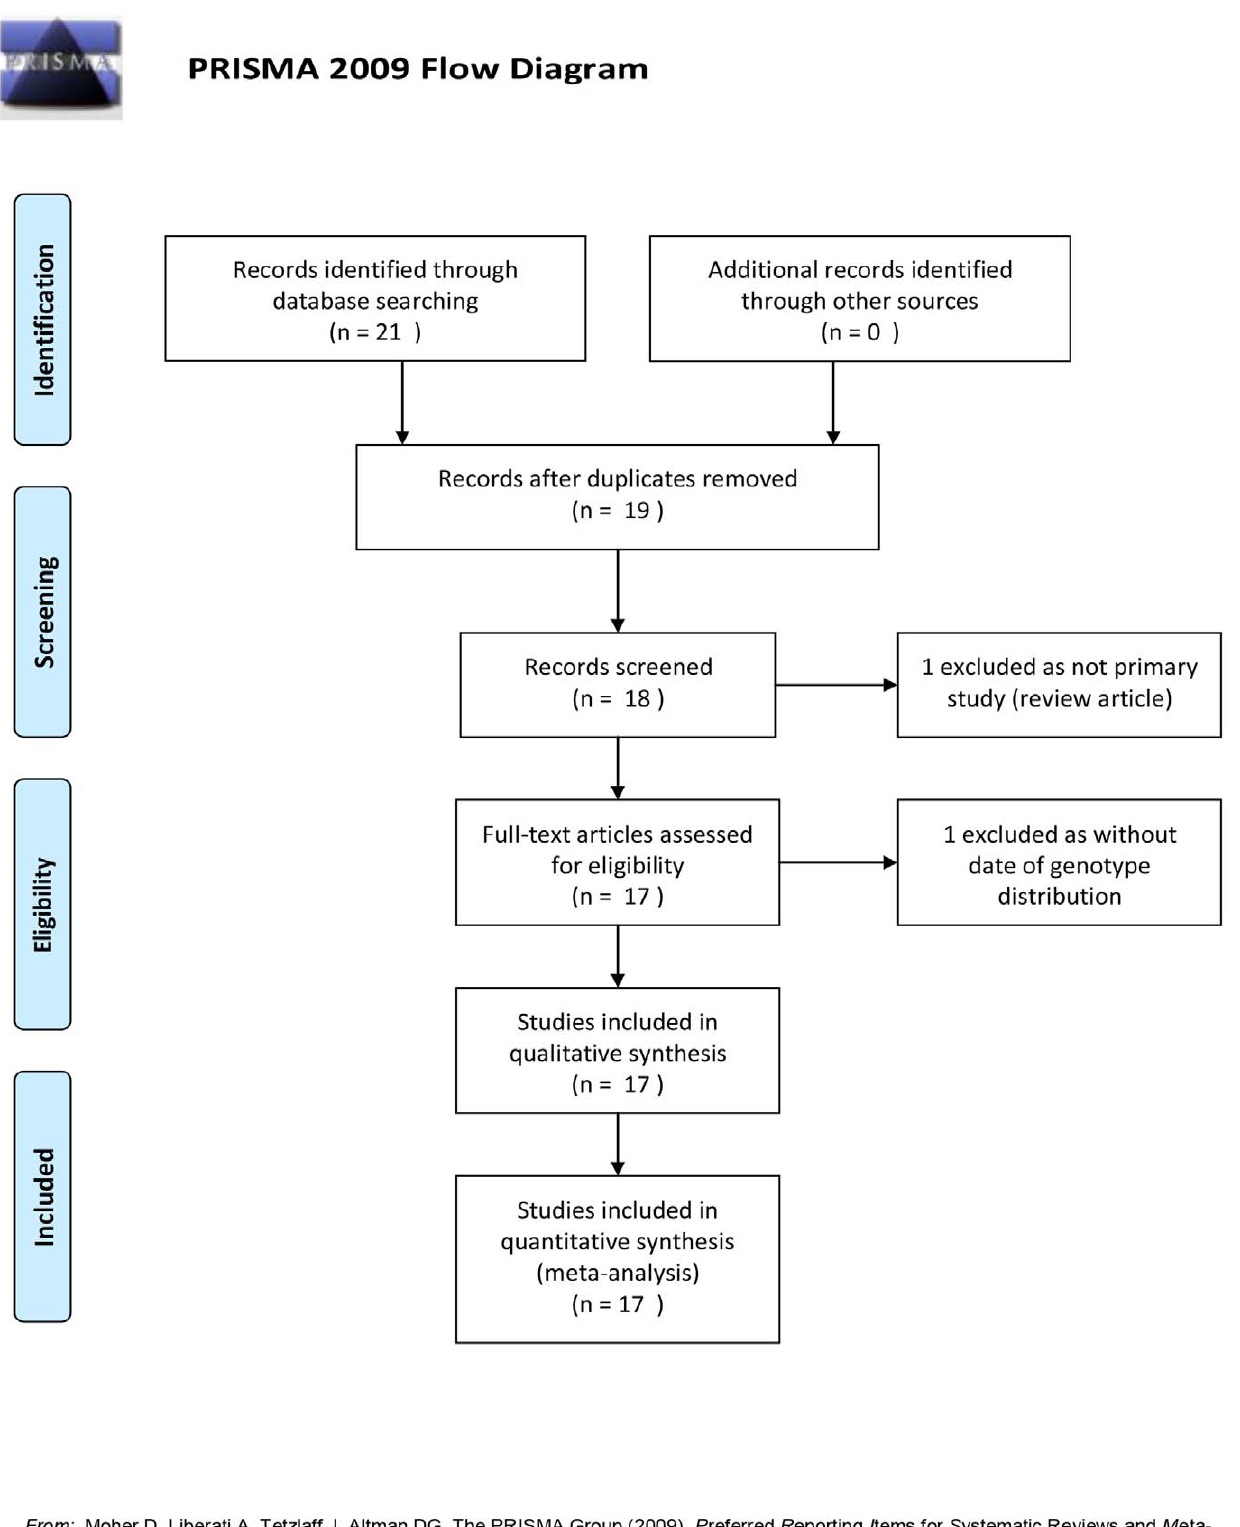
Figure 1. Flow diagram of search strategy and study selection.